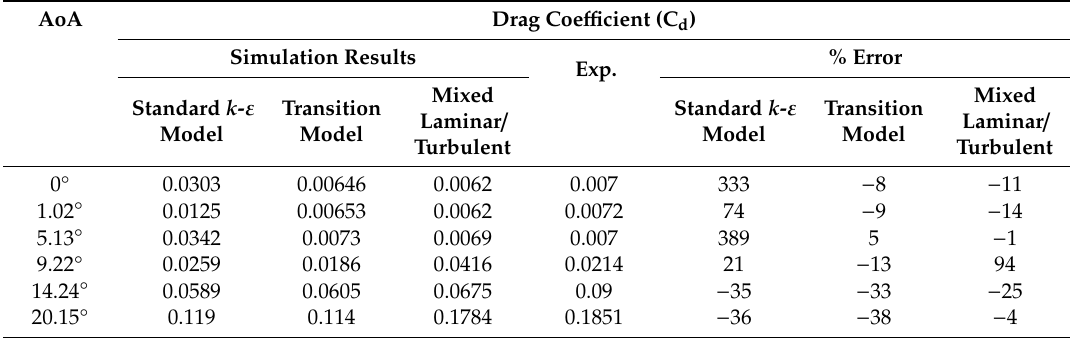
Table 2. Comparison between the simulation and experimental results for the drag coe ffi cient at